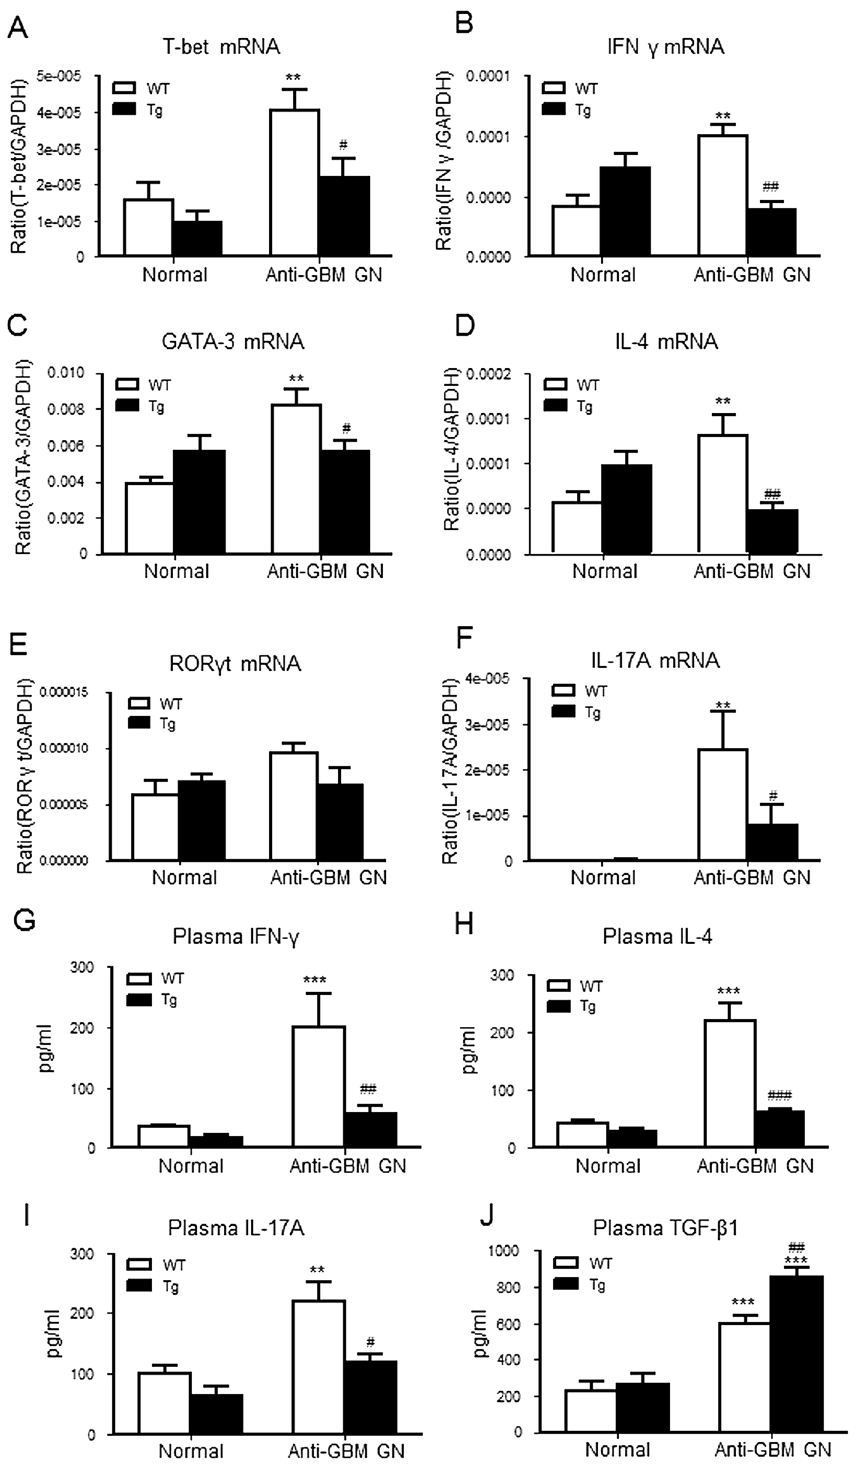
Figure 8. T cell-mediated proinflammatory immune response is attenuated in Foxp3 Tg mice with anti-GBM GN. Total kidney RNA was analysed by real-time PCR for the expression of molecules involved in the Th1 response including: ( A ) T-bet, ( B ) IFN- γ and the Th2 response such as: ( C ) GATA3 and ( D ) IL-4 and the Th17 response such as: ( E ) ROR γ t and ( F ) IL-17A. Levels of immune cytokines in plasma were measured by ELISA. ( G ) Circulating levels of the Th1 cytokine, IFN- γ . ( H ) Circulating levels of the Th2-cytokine, IL-4. ( I ) Circulating levels of the Th17 cytokine, IL-17A. ( J ) Circulating levels of the immunoregulatory cytokine, TGF- β 1. Each bar represents mean ± SEM. ** p < 0.01 and *** p < 0.001 compared with normal mice; # p < 0.05 and ## p < 0.01 and ### p < 0.001 compared with the WT mice. n = 6–8 mice per